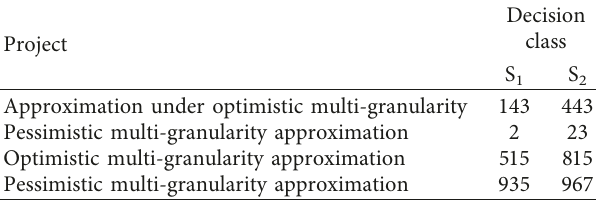
Table 3: Tic multiple granularity correlation approximations.